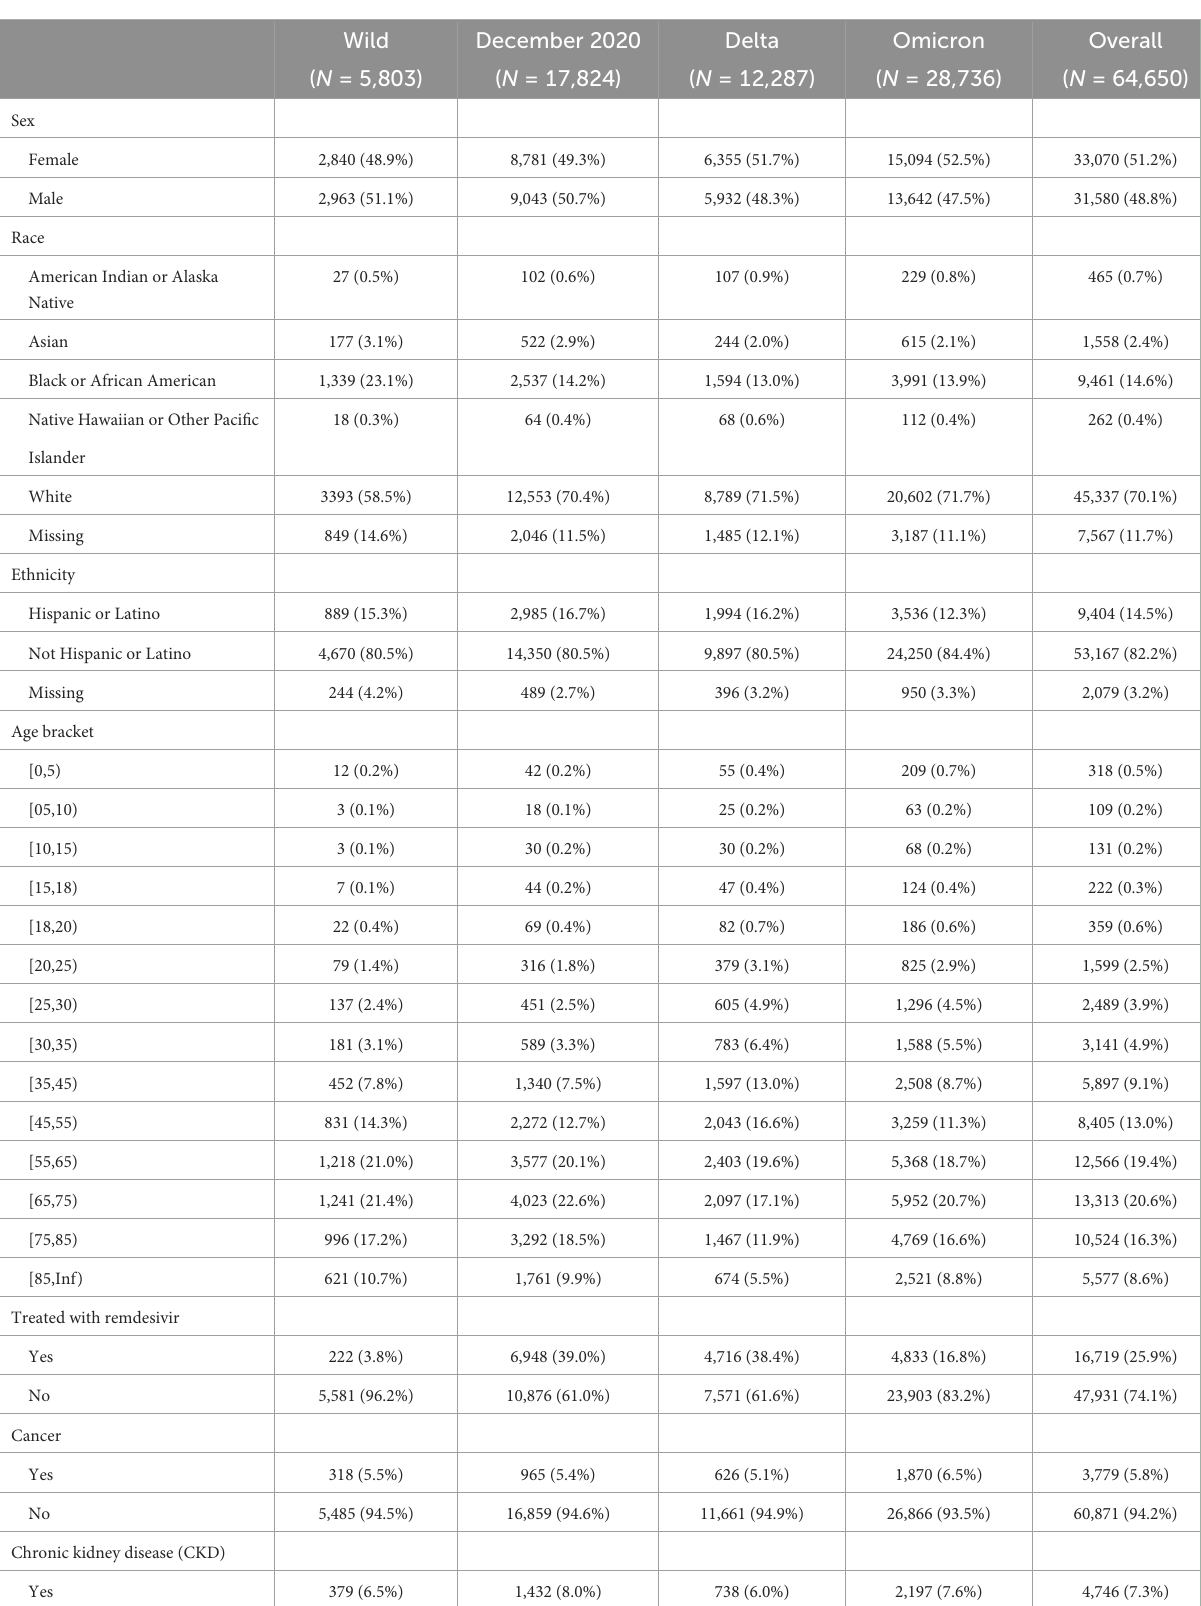
TABLE 1 Demographic characteristics of the population affected by each wave of COVID-19 and their comorbidities (the age distributions are given in Figure 2).